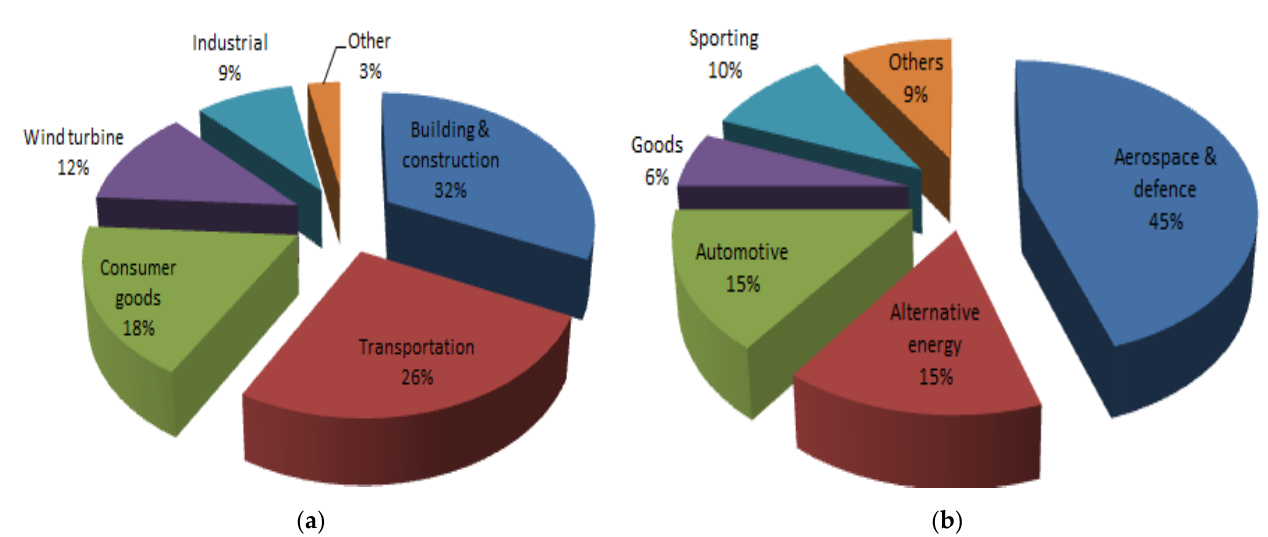
Figure 16. The main applications of glass ( a ) [187] and carbon ( b ) [188] fibers: automotive, alternative energy, aerospace, transportation, building, sport and others.